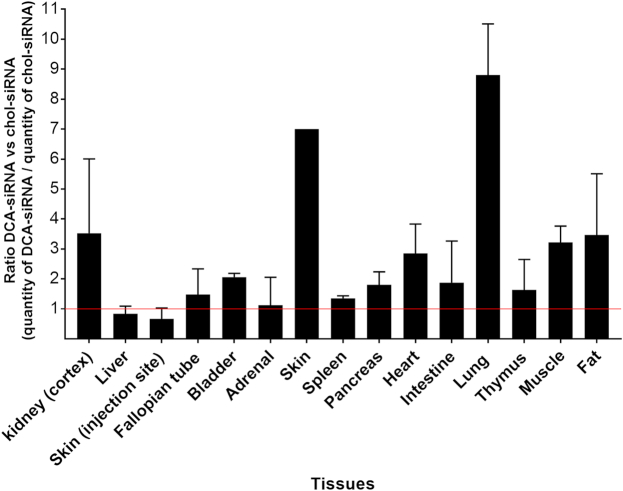
Relative improvement of DCA conjugated siRNA extra-hepatic tissue accumulation compared to cholesterol conjugated siRNA. Bar graph showing the ratio between the quantity of the DCA-siRNA antisense strands and cholesterol-siRNA antisense strands present in 15 tissues 48 h after a single subcutaneous injection with 20 mg/kg (n = 3 mice per conjugate ± SD). siRNA quantification was measured by PNA hybridization assay. DCA accumulation was 3- to 4-fold higher in heart, muscle and fat, ∼6-fold higher in skin (systemic) and 9-fold higher in lung.